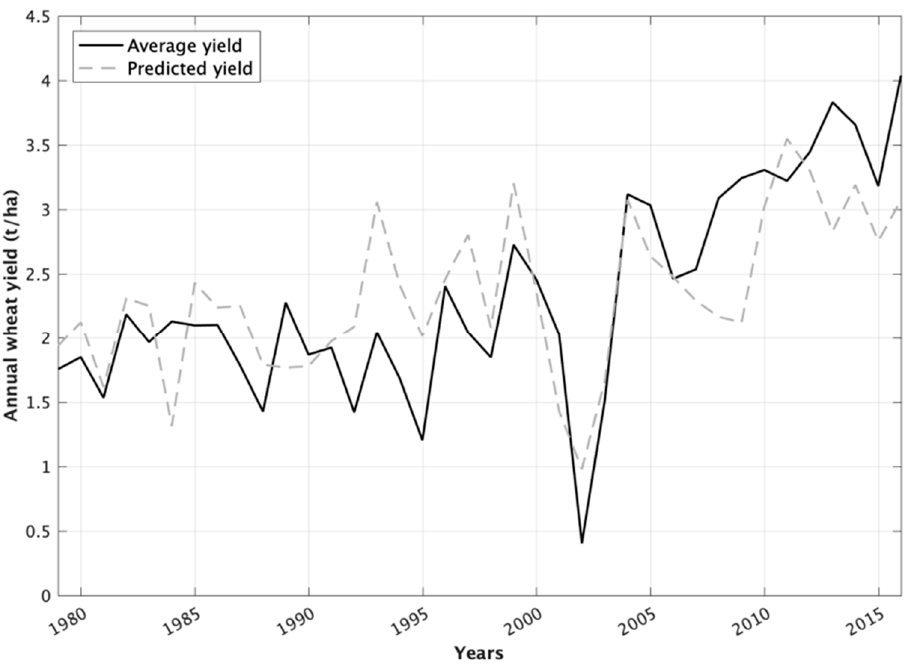
Figure 16. Average vs. predicted yield for rural municipality # 499 (1979–2016) (Orthic Gray soil zone).